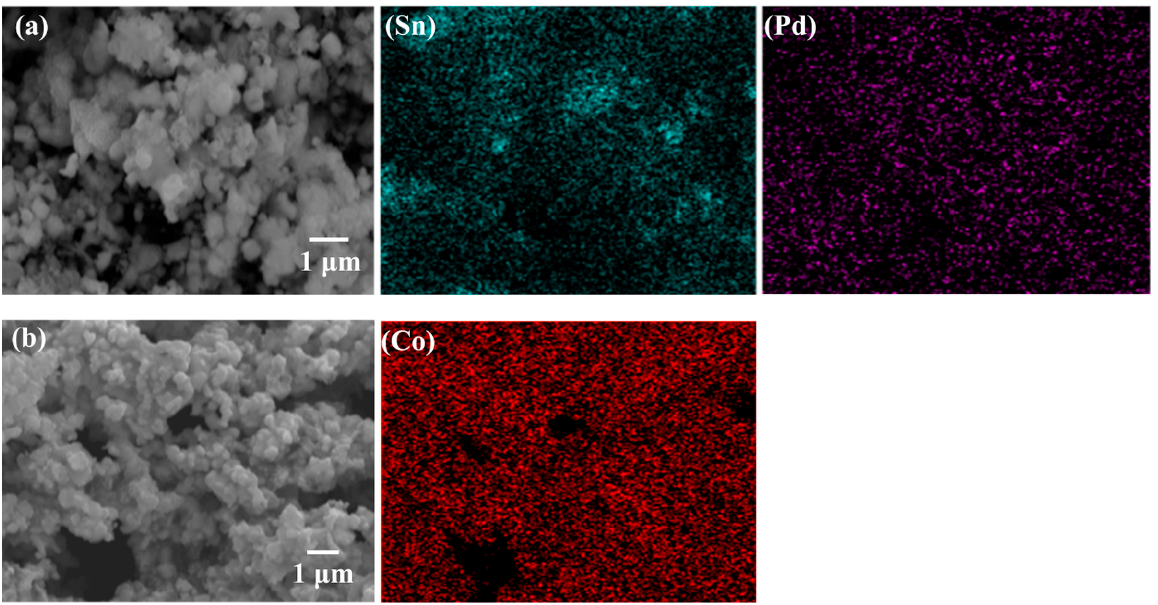
Figure 2. ( a ) SEM along with EDX mapping images of pre-treated Nd-Fe-B powder; ( b ) SEM along with EDX mapping images of the Co deposited powder.